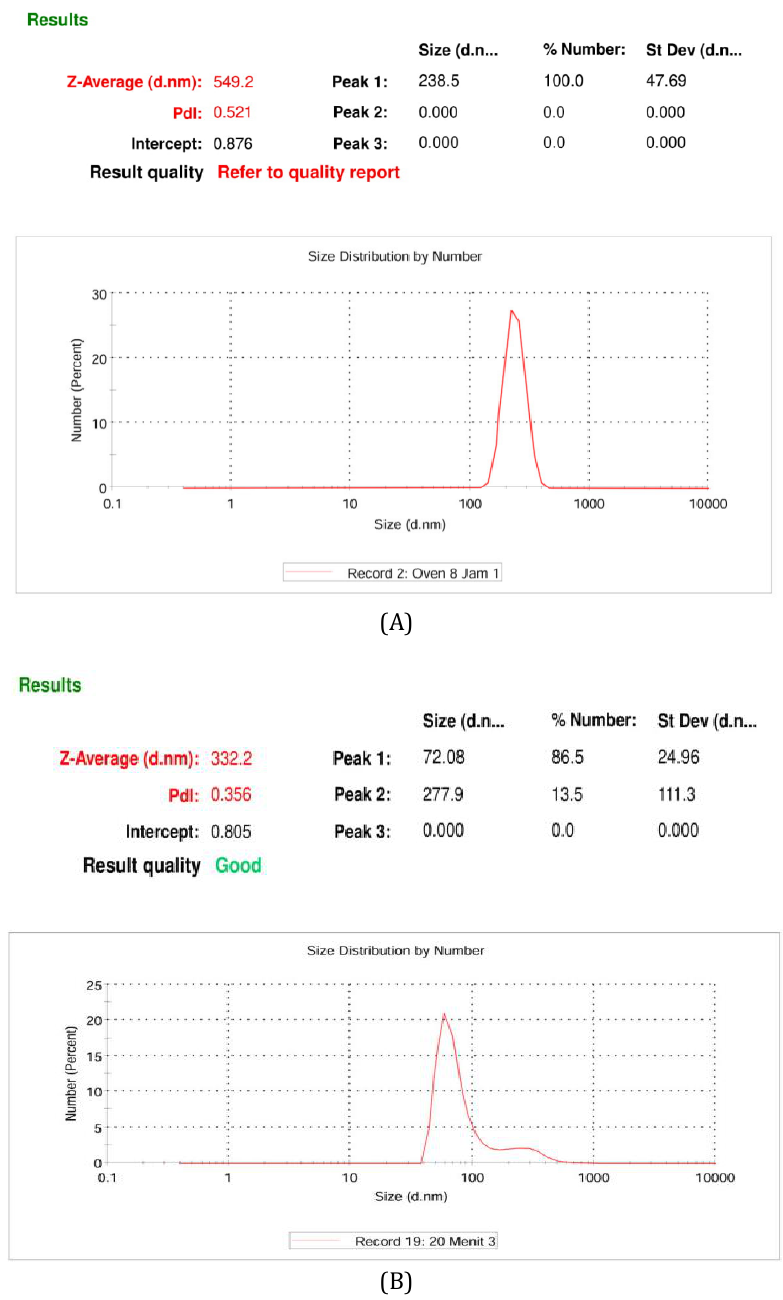
Figure 1. Measurement results of curcumin particles (A) before and (B) after pilling (nanocurcumin) using PSA wet